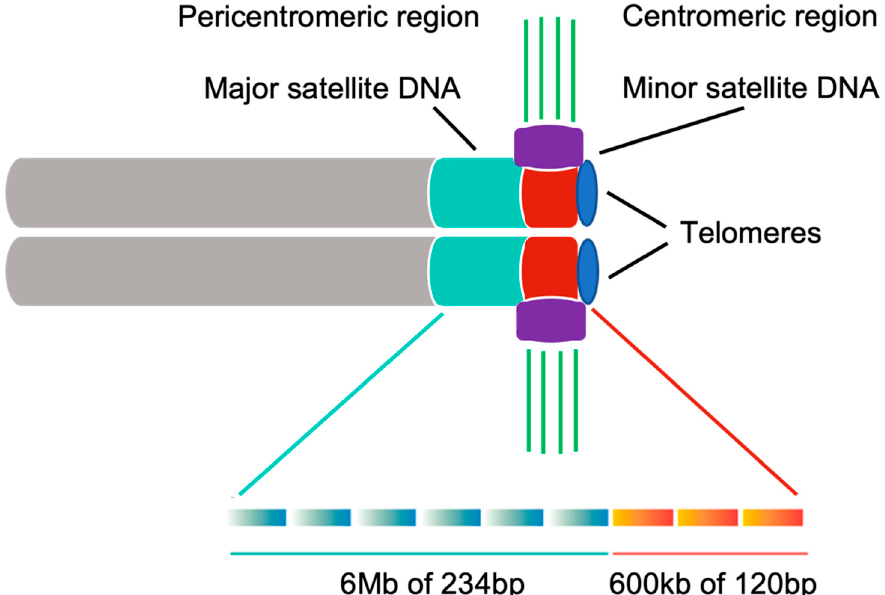
Figure 2. Major satellite repeats are localized at the pericentromeric region. Minor satellite repeats are localized at the centromeric region. Rectangular gradient shows the monomer for each satellite repeat. The kinetochore is mainly recruited to minor satellite DNA and attached by microtubules directly. Cyan: major satellite DNA; Red: minor satellite DNA; Purple: kinetochore; Green: microtubules; Gray: sister chromatids of a mouse chromosome; Blue: telomeres.